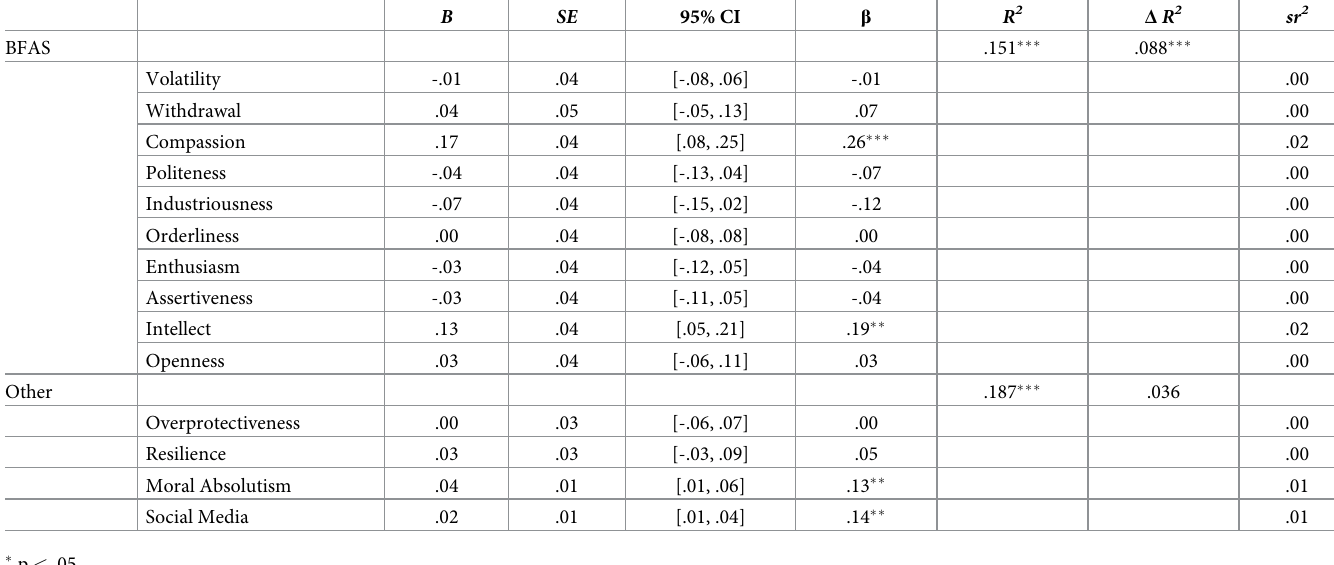
Table 4. Step 3 of the hierarchical multiple regression of BFAS, parenting, and personal factors with PCL.